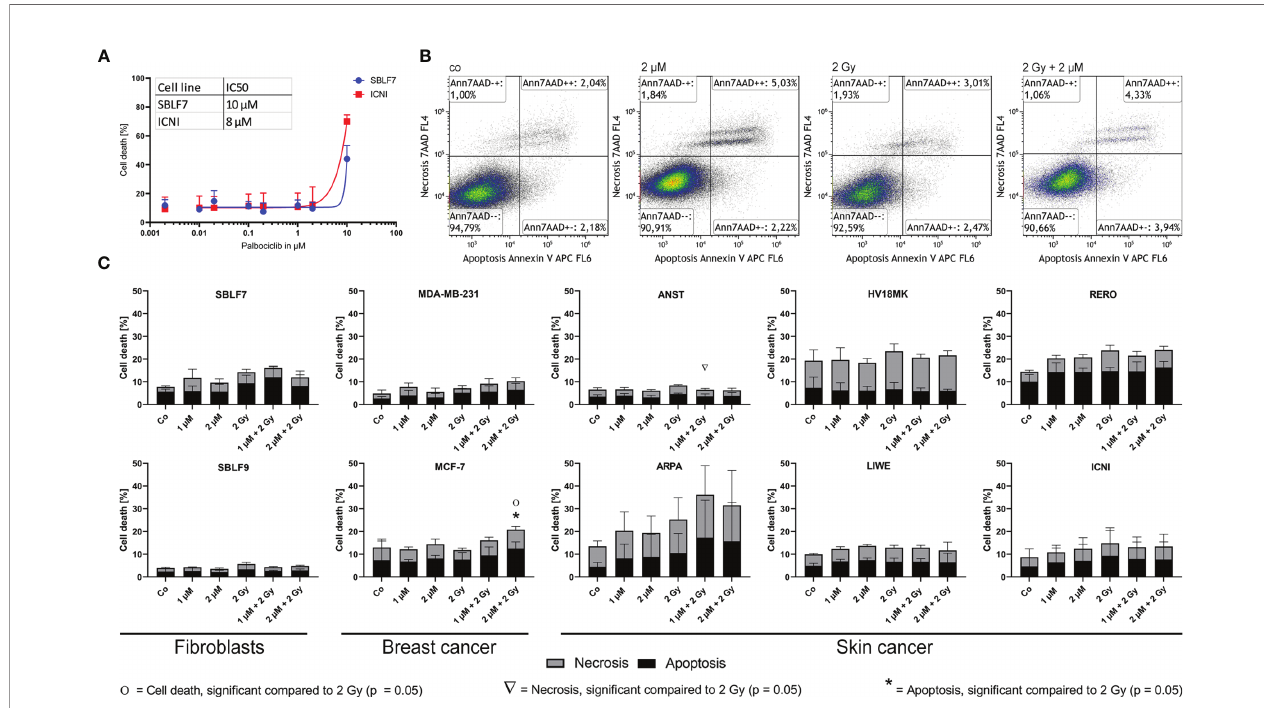
FIGURE 1 | Cell death analysis of different non-malign and malign cell lines. (A) Dose escalation study of the kinase inhibitor palbociclib in healthy fi broblasts and skin cancer cells [dose – response curve fi tting by non-linear regression of log(agonist) vs. response based on Graph Pad Prism]. (B) Gating strategy of the Annexin- 7AAD (cell death) staining of skin cancer cells RERO after KI treatment, irradiation, and combi therapy. (C) Necrotic and apoptotic populations in 10 different cell lines (healthy fi broblast SBLF7 and SBLF9, breast cancer MDA-MB-231 and MCF-7, and skin cancer ANST, ARPA, HV18MK, LIWE, RERO, and ICNI cells) after 48 h of treatment. Each value represents mean ± SD ( n = 3). Signi fi cance was determined by one-tailed Mann – Whitney U test Ο / D /* p ≤